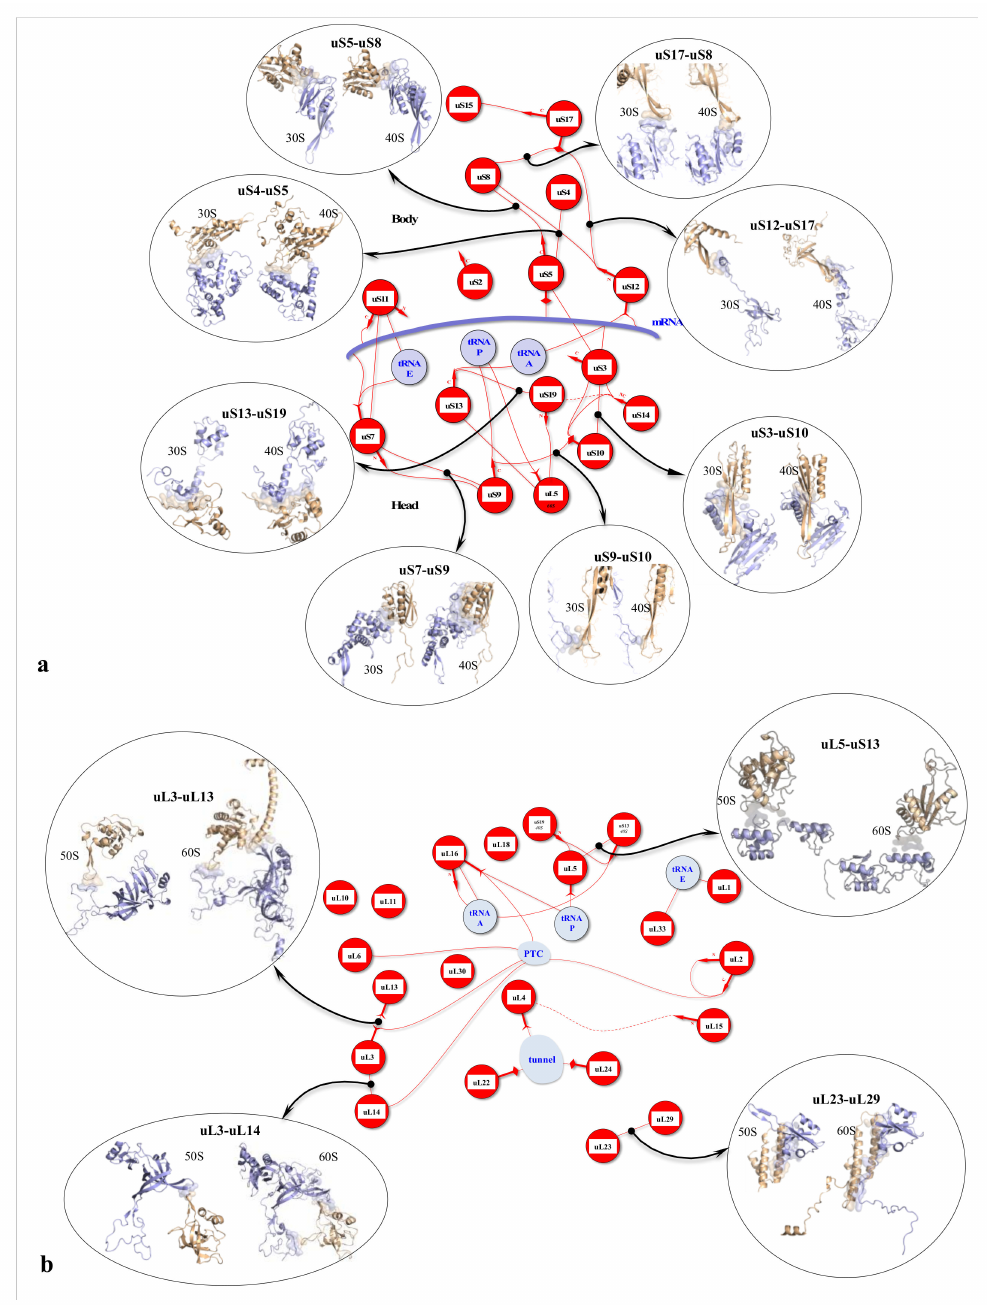
Figure 5. Universal r-protein network that probably predated the radiation of the three kingdoms. The interaction common in the small ( a ) and large ( b ) subunits of the ribosomal structures is shown by blue cartoons [46]. Conserved contacts between bacterial and eukaryotic ribosomal proteins are indicated by lines between the nodes of the network and represented by cartoons in the corresponding discs (left: bacteria (30S or 50S); right: eukaryotes (40S or